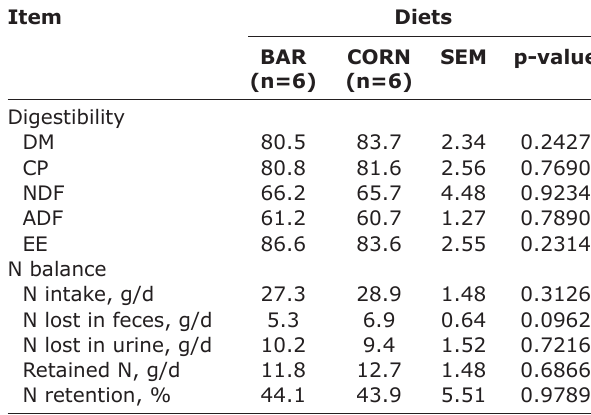
Table-3: Effects of feeding either BAR or CORN grains on nutrient digestibility and N balance of Awassi lambs.